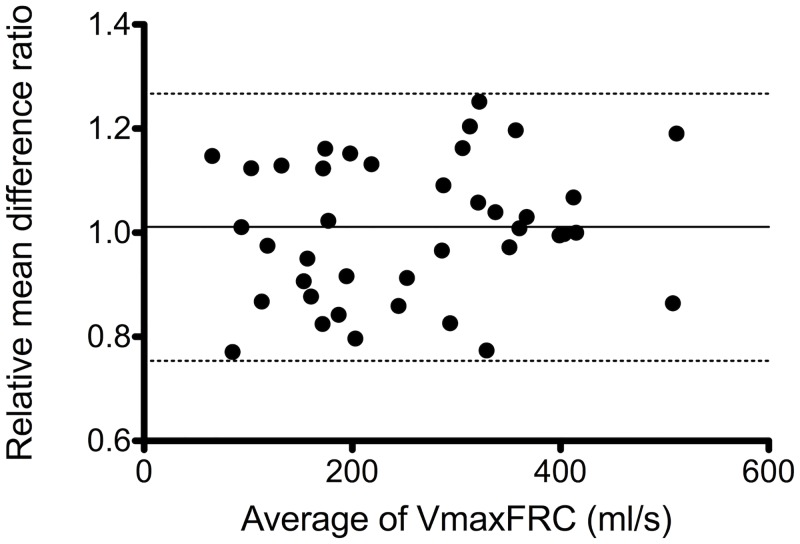
Short-term repeatability of VmaxFRC.Bland-Altman plot of the agreement in VmaxFRC is analyzed between two measurements sets 15 min apart. Data are plotted as the difference between two measurements versus the mean of the two measurements. Differences for individuals are shown as solid circles. The mean of the differences and the upper and lower limits of agreement are plotted as solid and dash lines respectively.